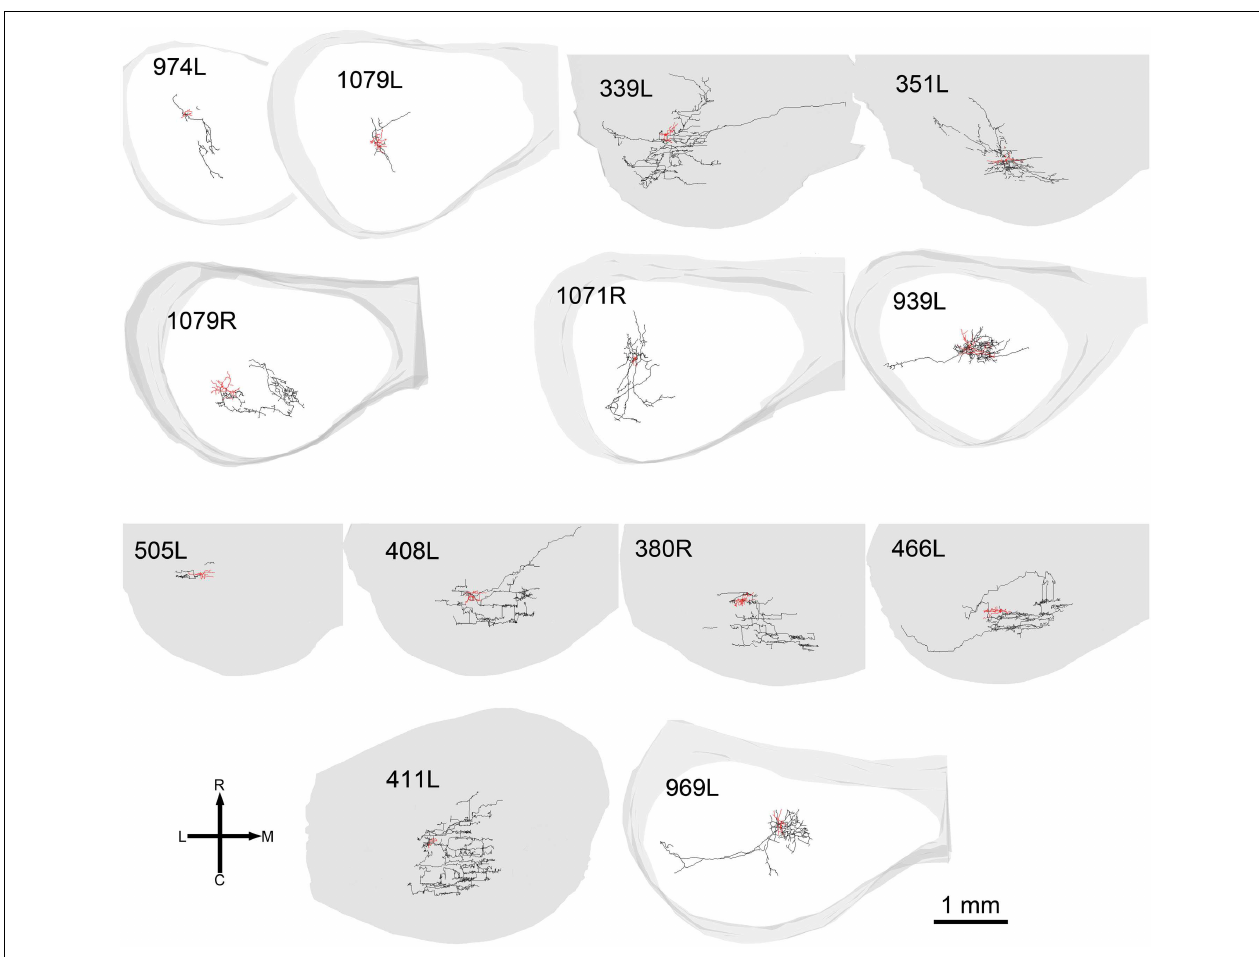
FIGURE 6 | Reconstructions of axons and dendrites of filled cells in the same format and order as in Figure 4 but viewed in the horizontal